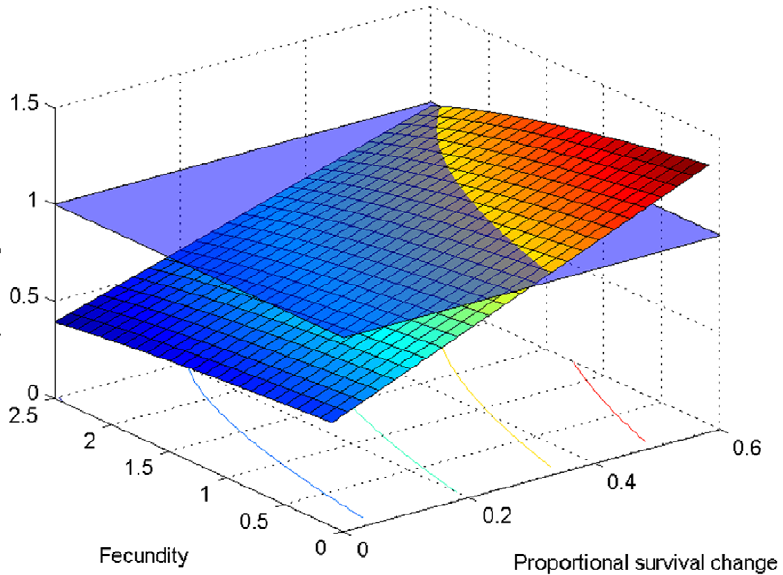
Figure 4. Age-independent relationship between population growth rate, fecundity, and proportional change in survival probability due to illegal poisoning. The blue horizontal plane represents population stability.